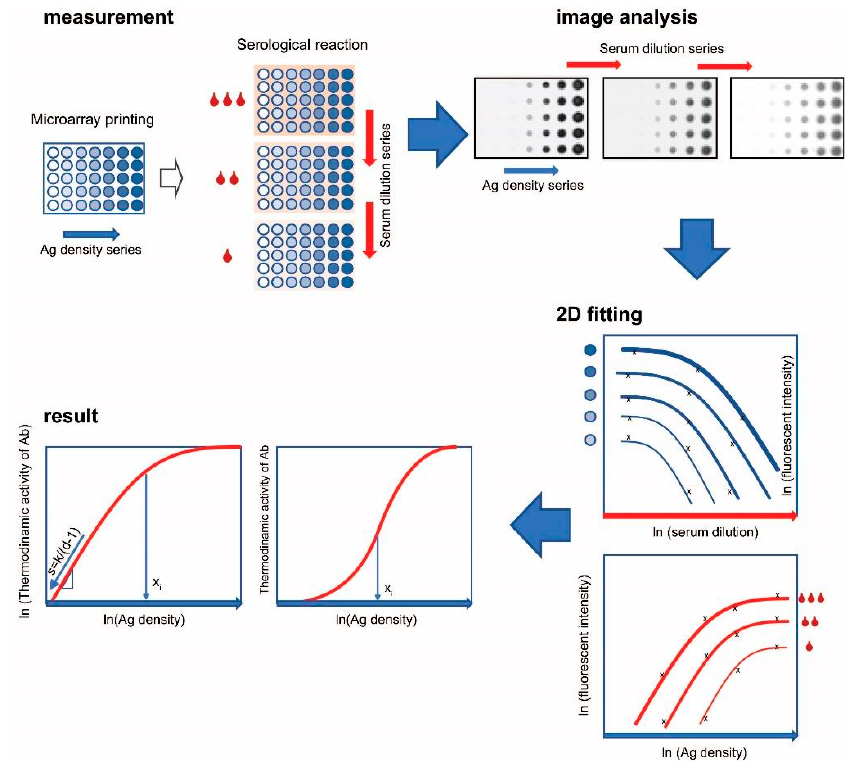
Figure 1. Simultaneous titration of antigen density and serum antibody. Steps of the technology, starting with microarray fabrication and measurement, through image analysis to curve fitting and visualization of results are shown. Serum dilution is indicated by red drops, antigen density differences are represented by shades of blue circles. Several binding curves are transformed into one by fitting data with generalized logistic curves, yielding two parameters, x i and d, which characterize thermodynamic activity distribution of serum antibodies. Affinity is related to x i , the point of inflection; antibody heterogeneity is related to d, the asymmetry parameter. The slope at infinity “s” of the curve in the lower left corner is given by the equation